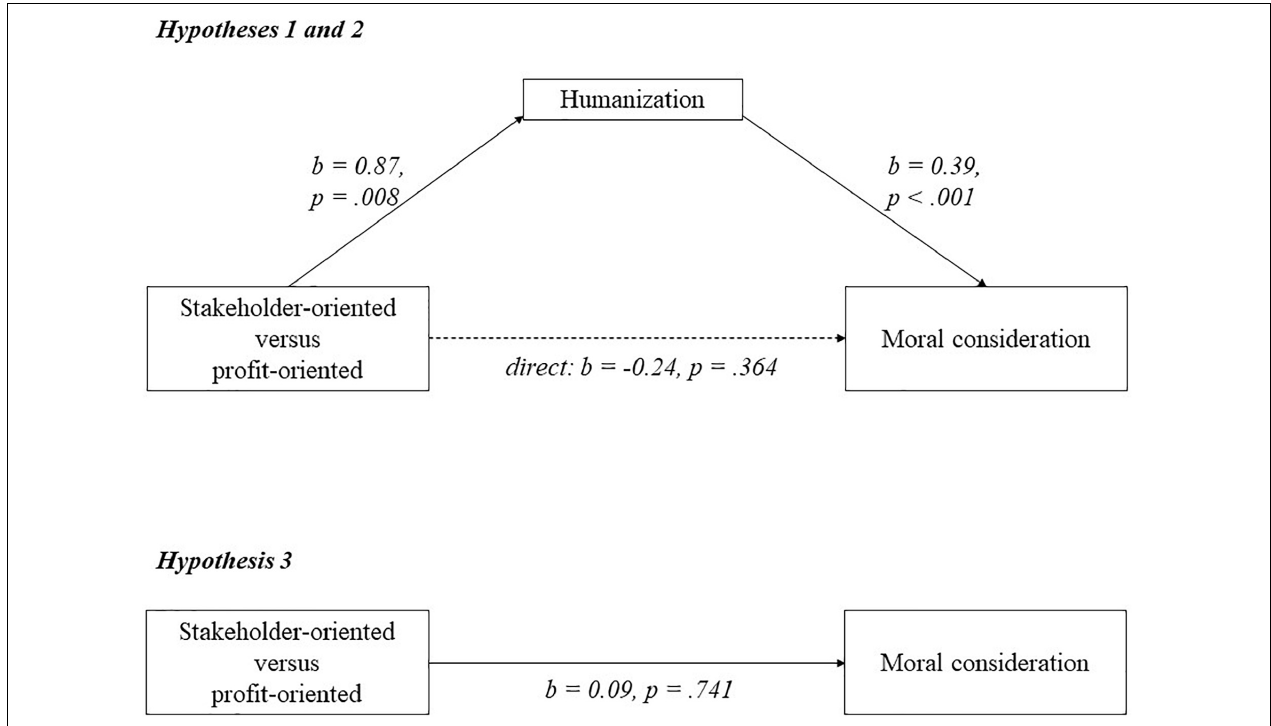
FIGURE 3 | A model of mediation indicating that the relationship between business orientation and moral consideration goes via humanization in experiment 4.